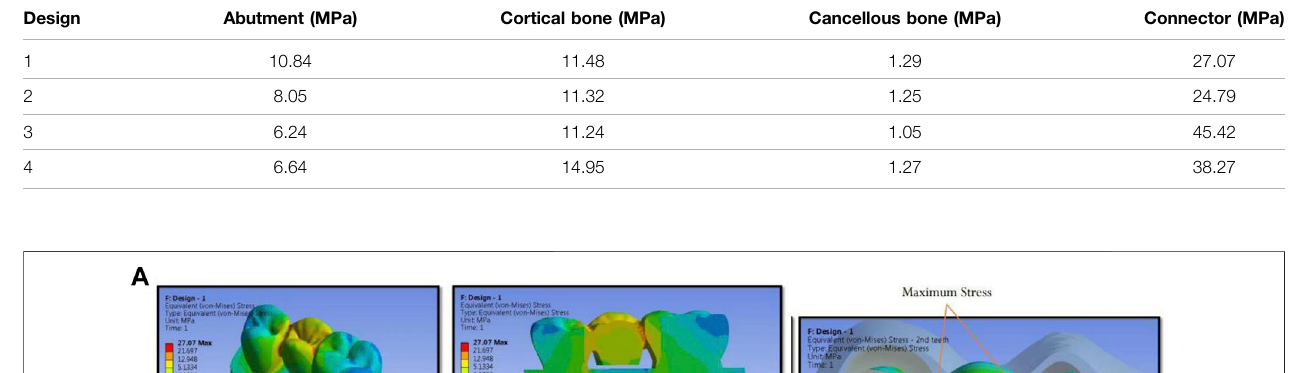
TABLE 2 | Comparison of stress distribution on the abutment, cortical bone, cancellous bone, and connector in all designs of resin-bonded fi xed partial dentures. Design